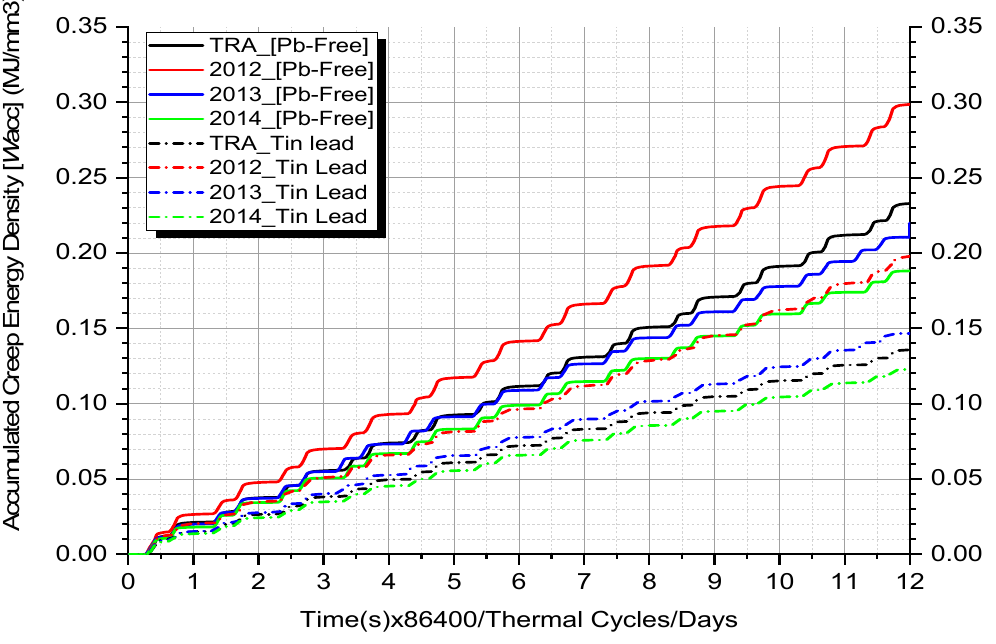
Figure 14. Accumulated creep energy density (ACED) response over 12 thermal cycles for: TRA, 2012, 2013 and 2014 thermal cycles.